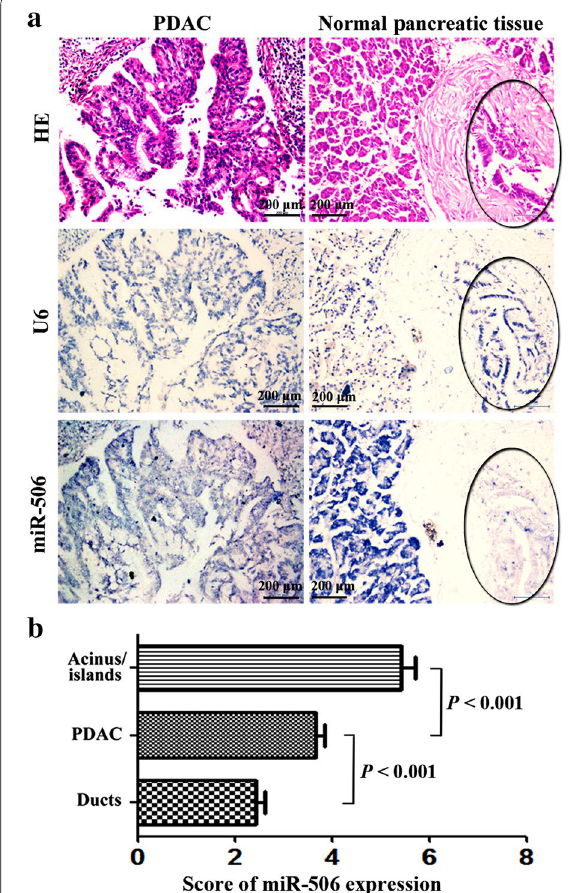
Fig. 1 The expression of miR‑506 in pancreatic ductal adenocar‑ cinoma (PDAC) and matched normal pancreatic tissues. a Repre‑ sentative images of hematoxylin and eosin (HE) staining, U6 in situ hybridization (ISH) (positive control), and miR‑506 ISH. The circles indicate normal pancreatic ducts. b Statistical analysis showed that miR‑506 expression in PDACs is significantly higher than that in normal pancreatic ducts but lower than that in normal pancreatic